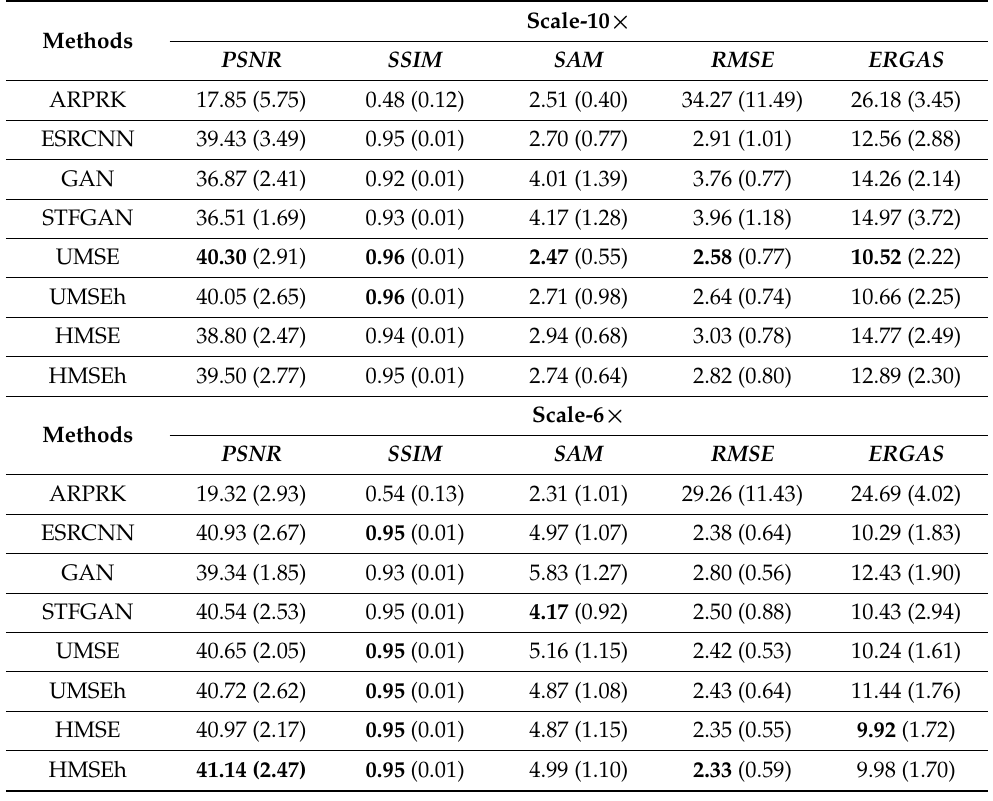
Table 3. Results of Experiment 1. ATPRK, ESRCNN, and GANs are competing methods. All others are the proposed model with different backbones or different loss functions. Results are averages for 20 testing images and shown in the format of “mean (std)”. Best results are shown in bold.